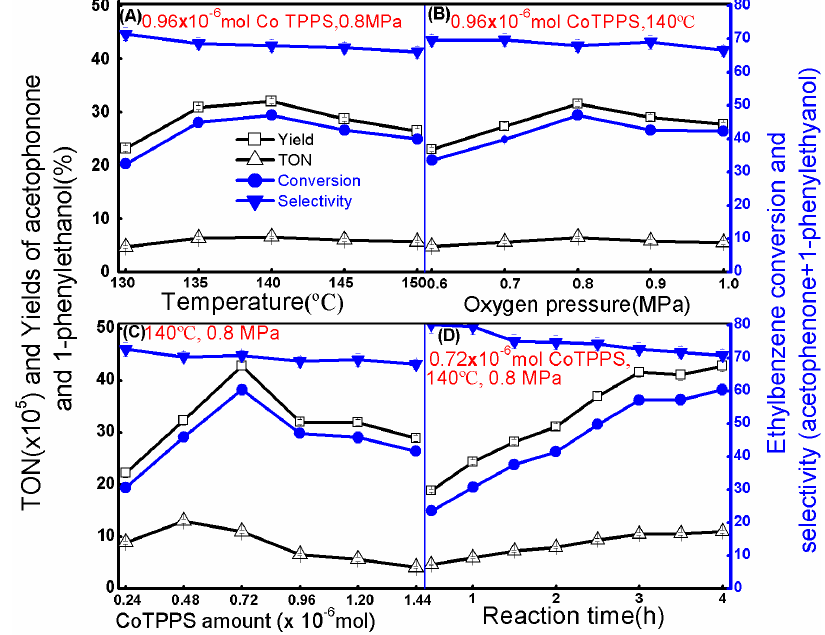
Figure 6. Optimization of ethylbenzene oxidation over Co TPPS/mesp-CTS. Reaction conditions: O 2 flow rate = 0.04 m 3 h − 1 . Catalyst turnover number (TON).